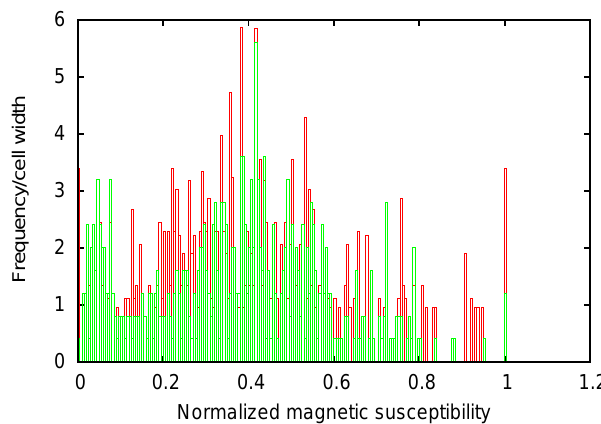
Fig. 3. Histogram of normalized magnetic susceptibility (red) from the 3 sites in the Huachuca Mountains and the best fitting multiplicative cascade model (green).